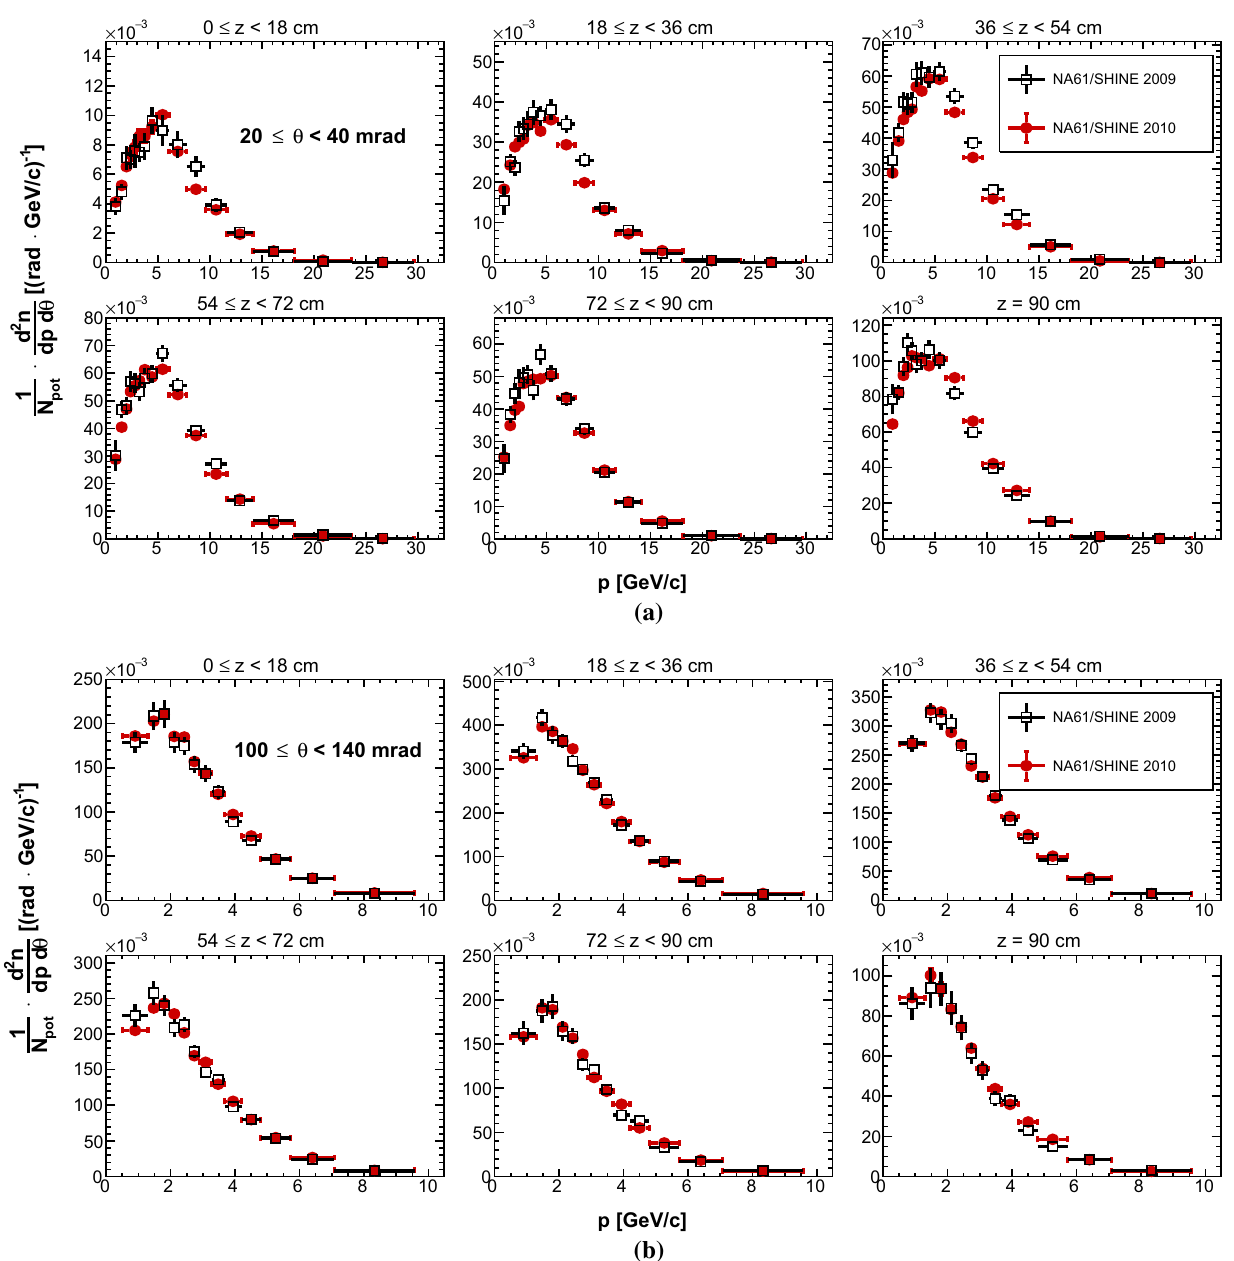
Fig. 53 Double differential yields of positively charged pions as a functionofmomentumforthepolaranglebetween20mradand40mrad ( a ) and between 100mrad and 140mrad ( b ). Each panel shows a differ-